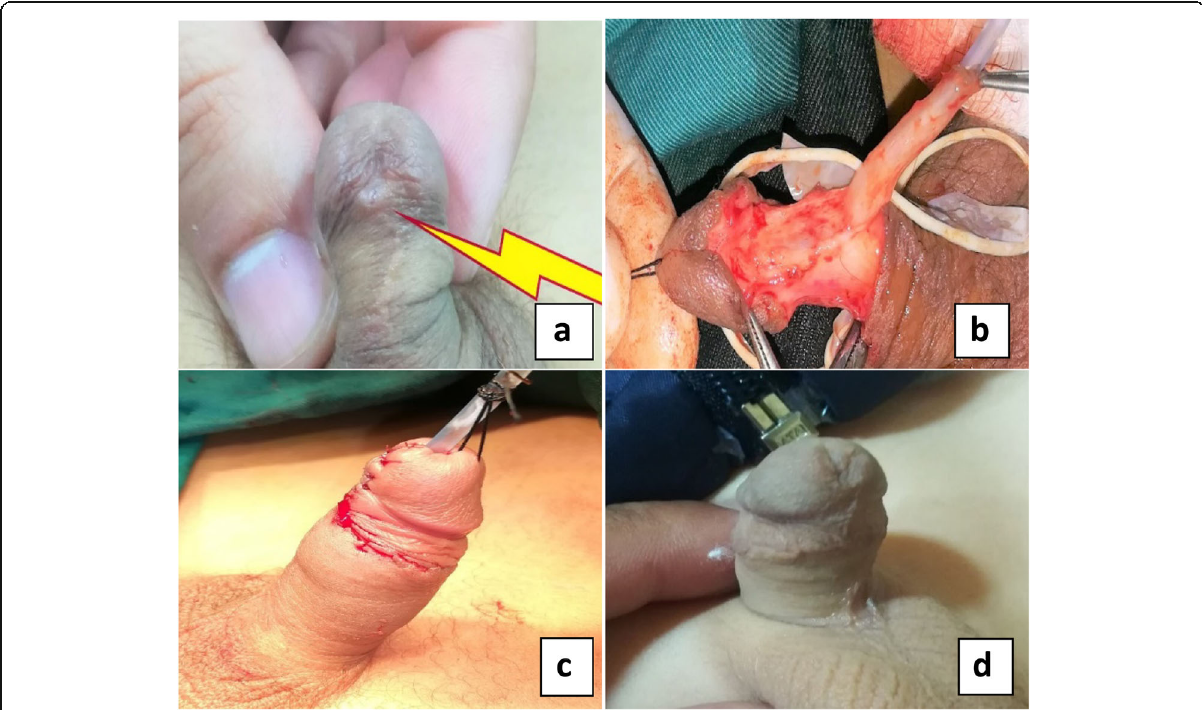
Fig. 1 a Circumcised hypospadias (preoperative). b after urethral mobilization. c at the end of surgery. d three months